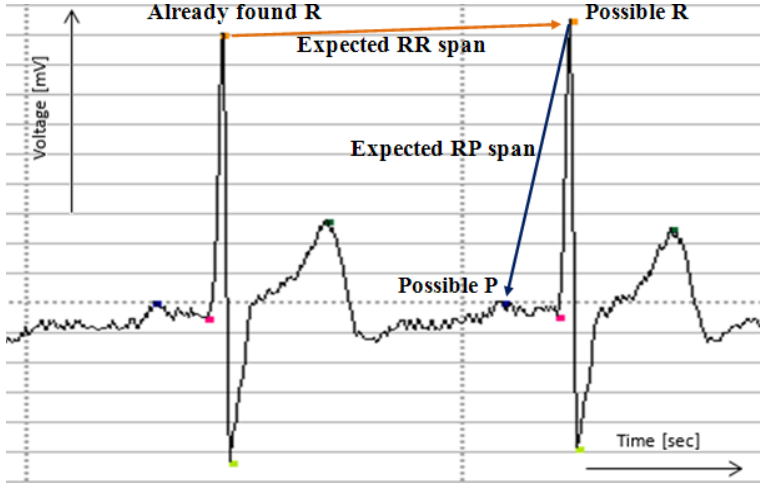
Figure 5. Finding of proper heartbeats on the example of R and P points. The signal and the markings of characteristic points are drawn by the authors’ simulation